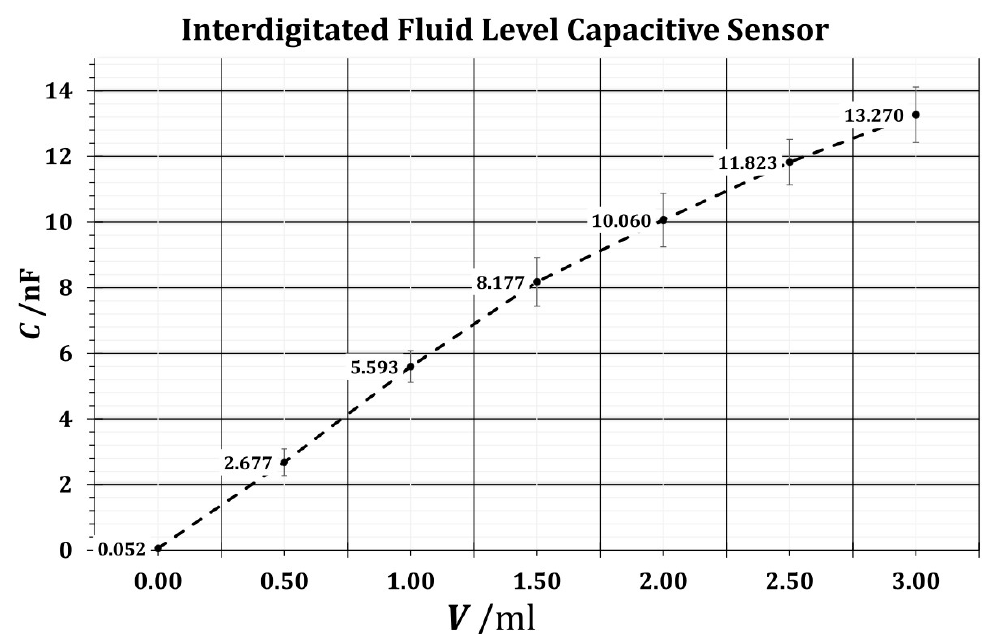
Figure 2. Graph showing the dependence of the interdigital sensors capacitance C on increasing filling volume V of DI-water. The measurements were made at room temperature between 24 and 25 °C using an HP4278A capacitance meter. The initial tests show a strong dependence of the capacitance on the increasing volume. The plotted curve is the average of three measurements with the error bars being the standard deviation. The sensor has an average capacitance of C = 0.052 nF while empty (air gap) and 13.27 nF while completely